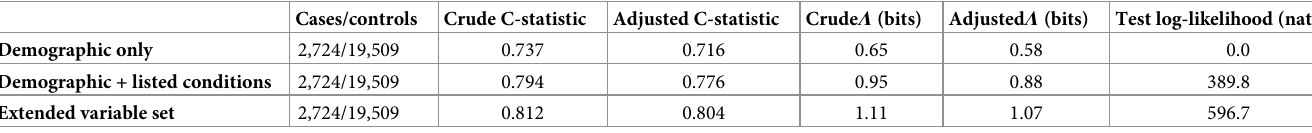
Table 5. Prediction of severe COVID-19: Cross-validation of models chosen by stepwise